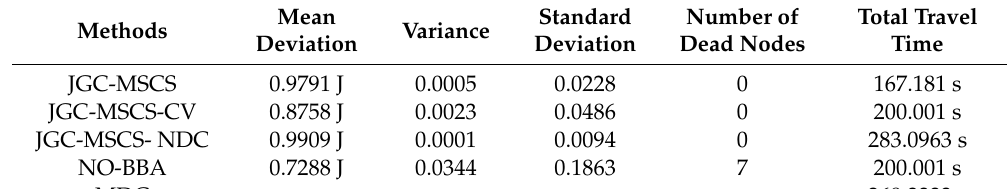
Table 3. Comparison table of remaining energy of nodes.